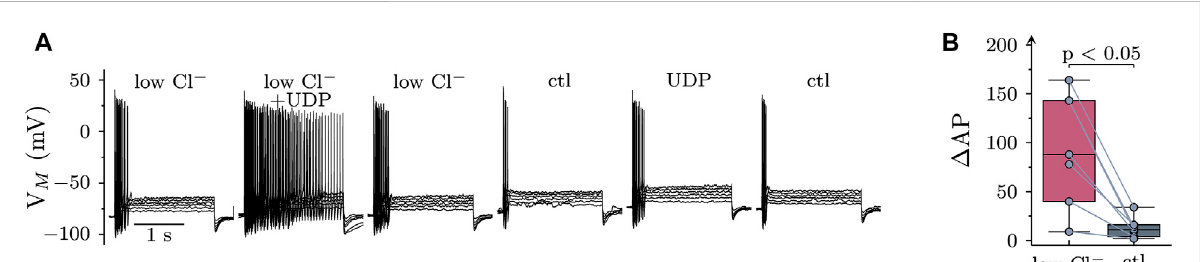
Role of extracellular chloride in the effects of UDP on sympathetic neuron excitability. Membrane potential was measured in perforated-patch current clamp in single SCG neurons, and 6 depolarizing 2 s currents with amplitudes of 50, 100, 150, 200, 250, and 300 pA were injected to trigger actionpotentials. (A) OriginalcurrentclamptraceswereobtainedinalowCl − solution(89 mM;lowCl − ),andcurrentinjectionwasperformedbefore, during,andafterapplication ofUDP(1 µMfor120 s);thereafter,thisprotocolwasrepeatedinstandardCl − solution(149 mM). (B)